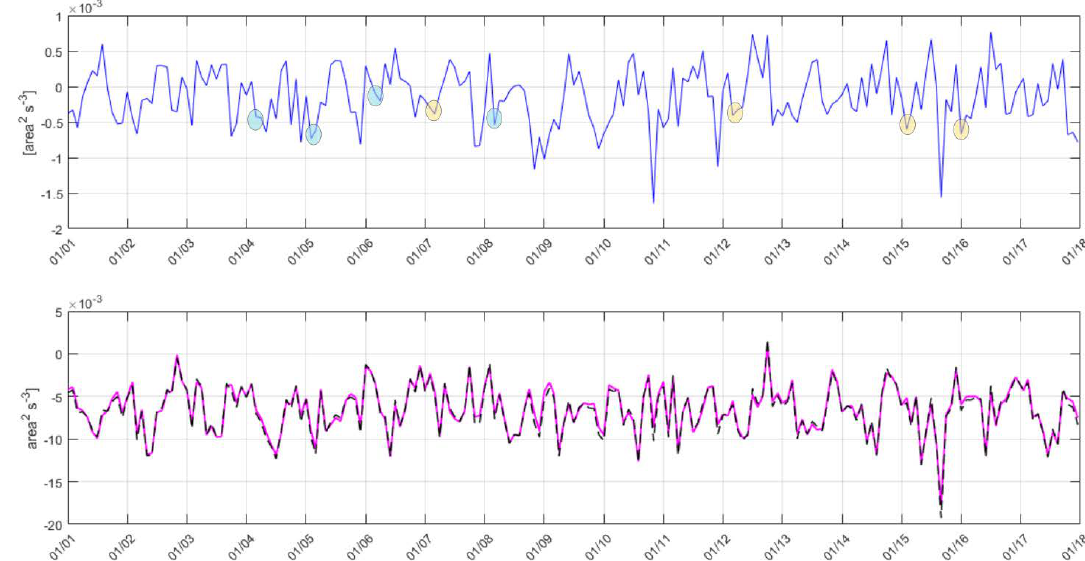
Figure 4. Upper panel: Time series of the monthly thermal component (B T ) from 2001 to 2017, integrated over the center of RG (longitude: 28 – 31°E, latitude: 34 – 36°N). Blue and yellow circles indicate events of pronounced dense water formation detected by the Argo floats within RG and along the coastline, respectively (Table 1). Lower panel: Time series of the monthly haline component (B S ; magenta line) and buoyancy fluxes (B; black dotted line).